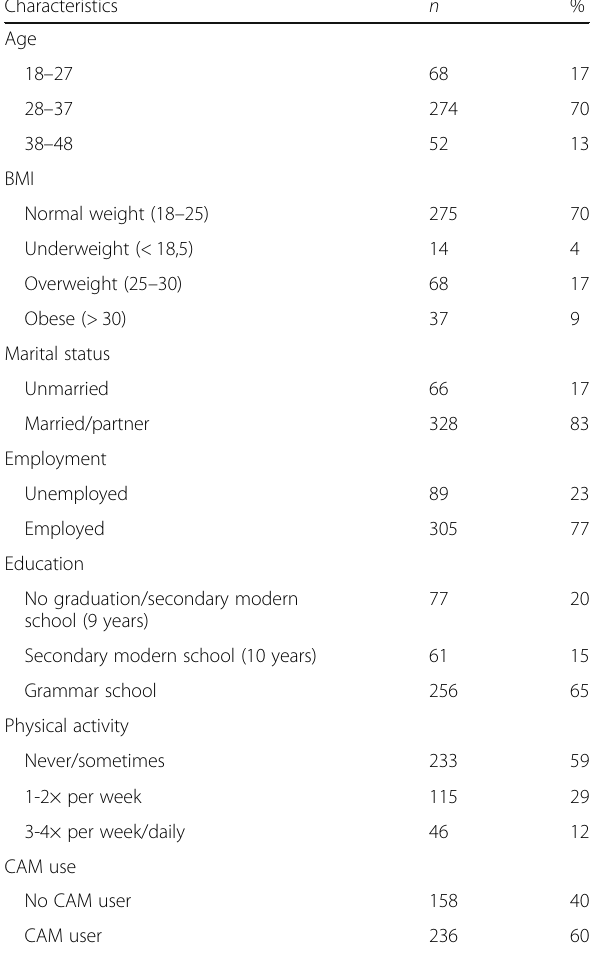
Table 1 General characteristics of the study population ( n = 394) Characteristics